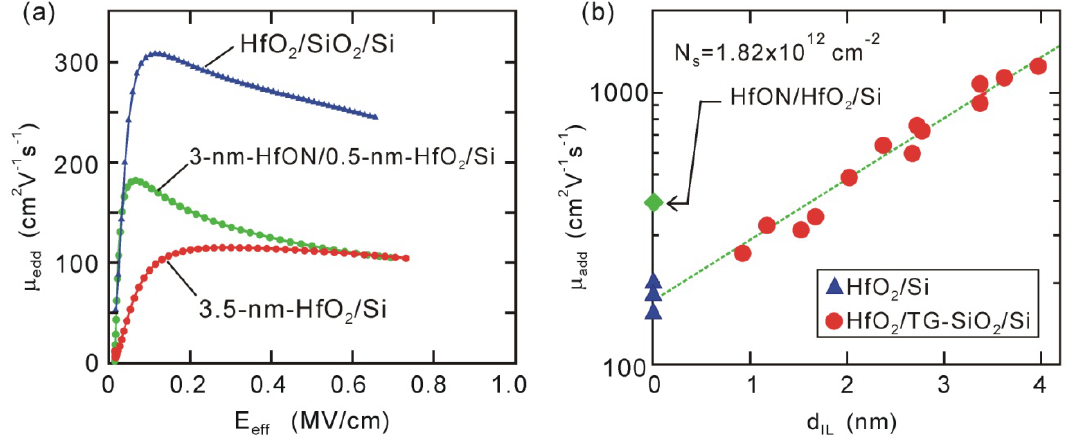
/Si and HfON/HfO 2